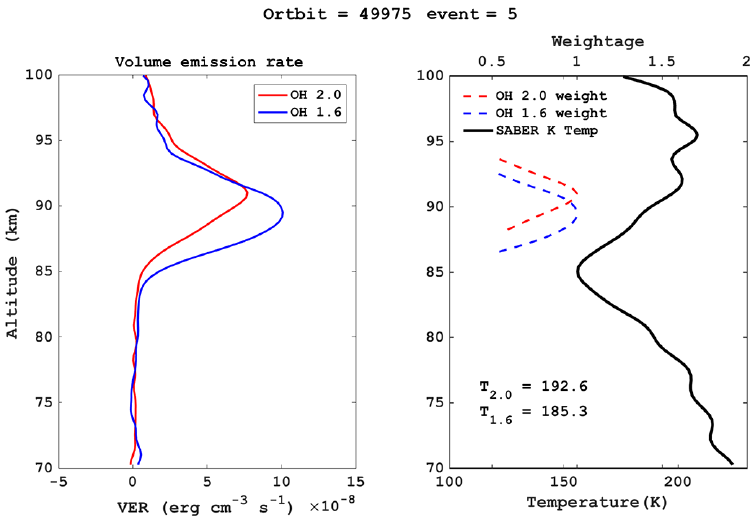
Figure 4. Same as Fig. 2 but for Orbit 49975 Event 05 of 28 February 2011.